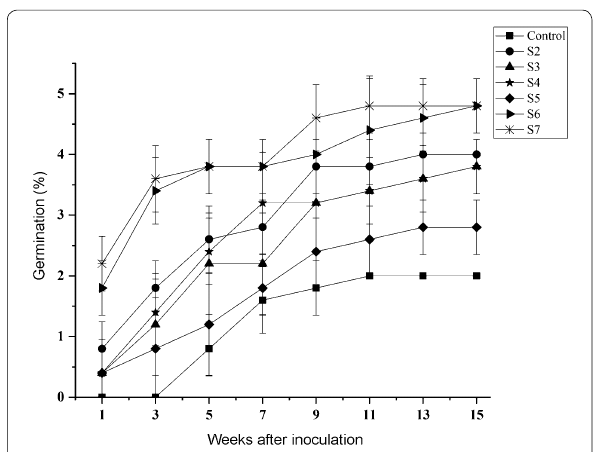
Fig. 3 Germination rate of D. officinale seeds inoculated with different fungal strains. After 1 week of inoculation, germination was recorded for each treatment every 2 weeks. Data are mean (n 3) =